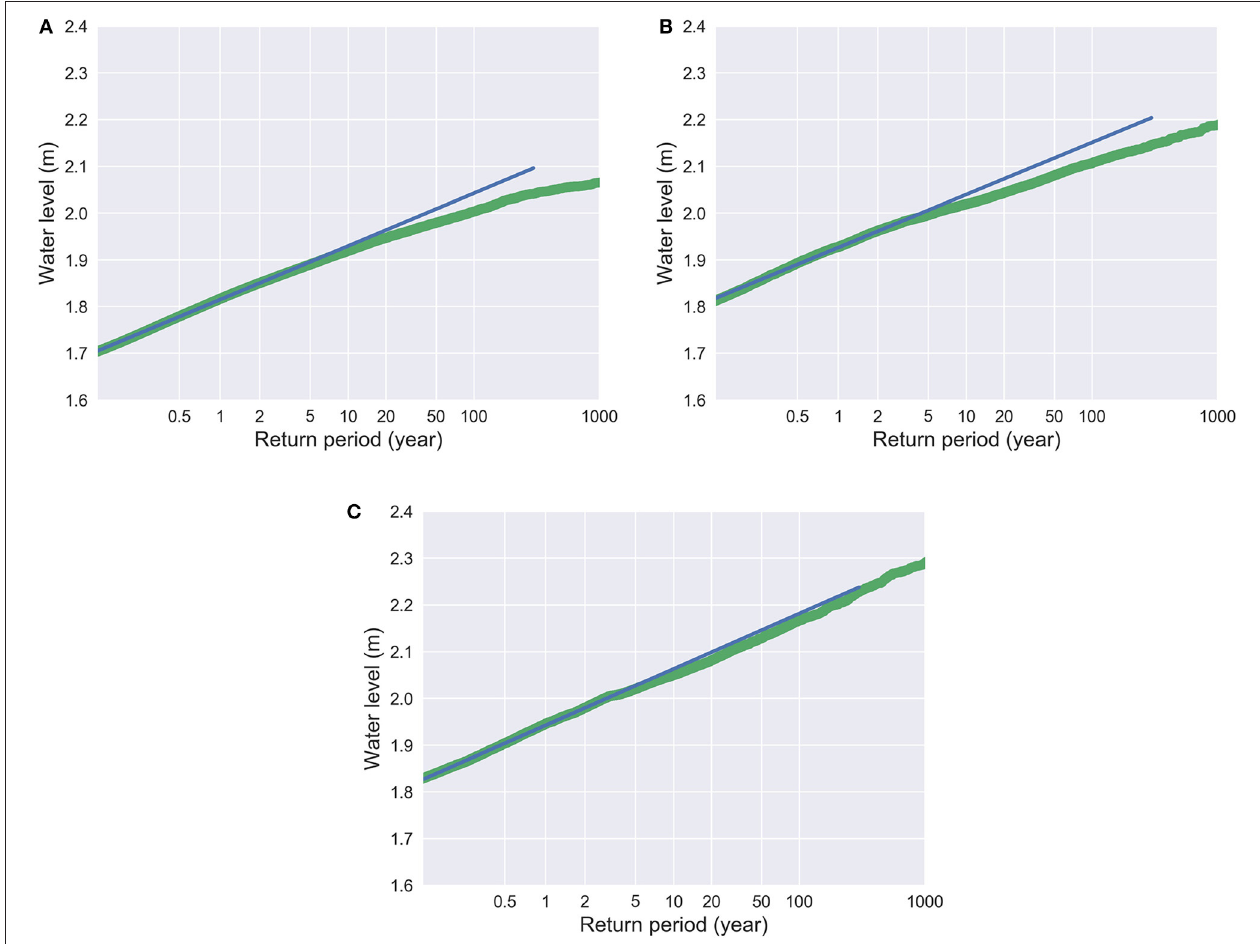
FIGURE 6 | Flood frequency curves at Can Tho for Present (A) , and for 2050 corresponding RCP 4.5 (B) and RCP 8.5 (C) . Blue line indicates the fitted Gumbel distribution while the green line indicates 1D hydrodynamic model output.